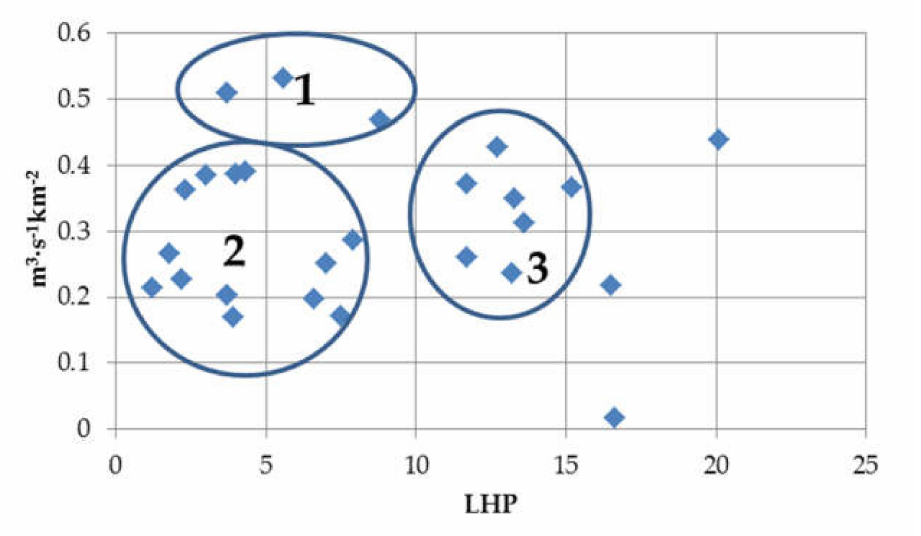
Figure 10. Relationship between landscape hydric potential ( LHP ) and peak rate discharges; circles show clusters with similar features of